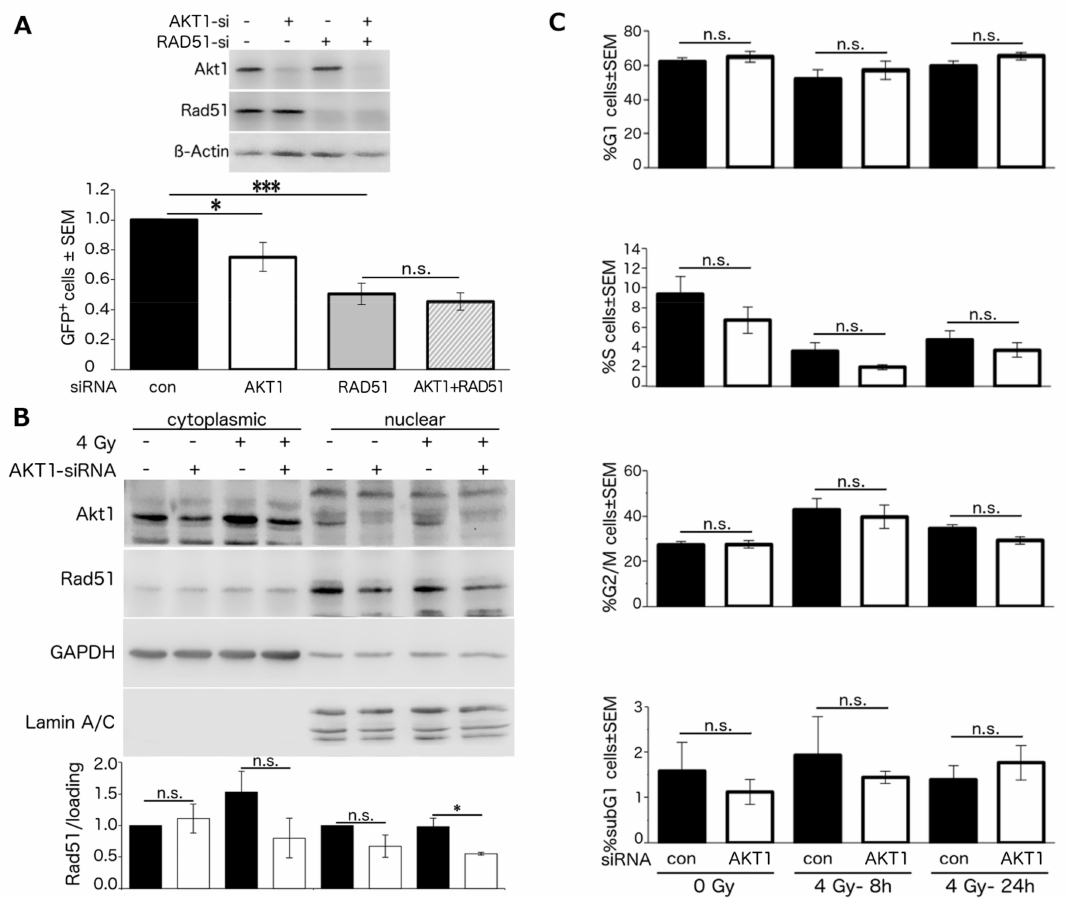
Figure 2. Stimulation of HR repair by Akt1 is dependent on Rad51. ( A ) HR-reporter assay was performed in A549 cells after transfection with the indicated siRNAs. The fraction of con-siRNA transfected cells, which were GFP-positive, equaled 0.46 ± 0.10%, for Akt1-KD 0.33 ± 0.05%, for Rad51-KD 0.24 ± 0.05%, for Akt1-KD+Rad51-KD 0.20 ± 0.03% (raw data). The raw values of GFP-positive cells were normalized to con-siRNA transfected cells. Asterisks indicate significant reduction of GFP-positive cells by Akt1-KD and Rad51-KD ( n = 4, at least 8 data points; * p < 0.05, *** p < 0.001); ( B ) following transfection with AKT1-siRNA, A549 cells were irradiated, and 8 h later, the cytoplasmic and nuclear fractions were prepared. Rad51 protein levels were determined by Western blotting. GAPDH and Lamin A/C were used as cytoplasmic and nuclear markers, respectively. Densitometry is based on the mean ± SEM of 3 independent experiments. Akt1-KD significantly reduced Rad51 protein level (* p < 0.05); ( C ) A549 cells were treated with AKT1-siRNA, harvested at the indicated time points post irradiation, and cell cycle distribution was examined ( n = 3, 6 data points). n.s., not